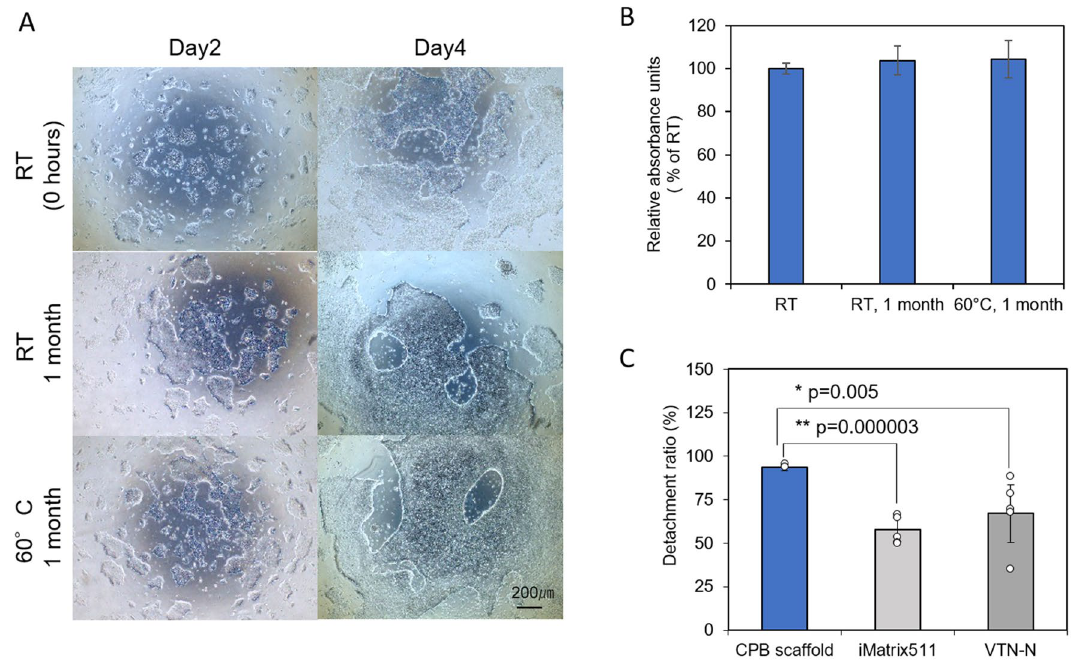
Figure 3. Temperature effect on peptide-polyvinyl butyral-based coated tissue culturing polystyrene and analysis of detachment of cells on different substrates. ( A ) 253G1 colony morphology using incubated CPB scaffold at room temperature and 60 ºC for 1 month, ( B ) Relative absorbance unit of 253G1 after five days of culturing in TeSR-E8 medium after seeding 5 × 10 4 cells on CPB scaffold. Data are presented as mean ± SD of three independent experiments. ( C ) Detachment ratio of 253G1 cells cultured on CPB scaffold compared with VTN-N and iMatrix 511. Scale bars is 200 µm. Data are presented as mean ± SD of six independent experiments (* P < 0.05 compared to VTN-N, ** P < 0.005 compared to